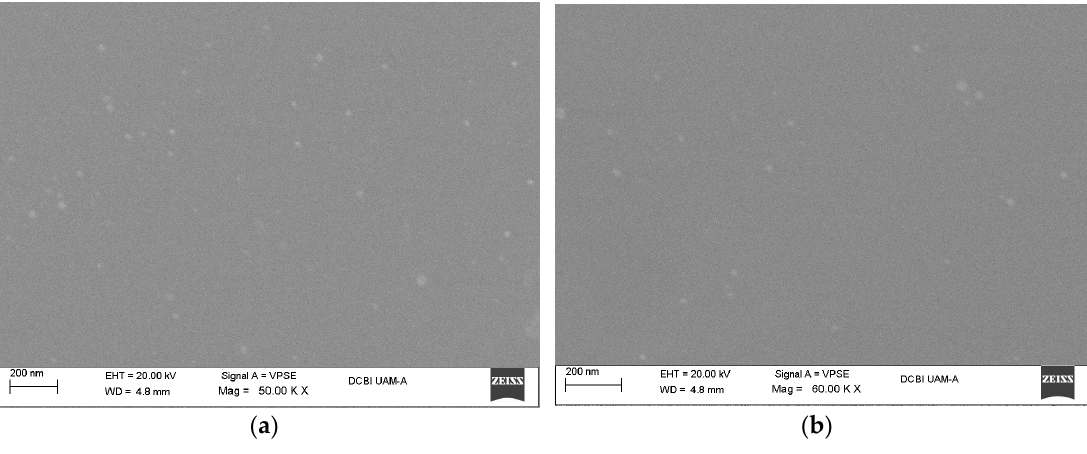
Figure 1. SEM micrographs of the silica nanoparticle dispersion with a 0.75 PHR (part of SiO 2 per hundred parts of resin) content, employing the sol-gel in situ technique: ( a ) Tetraethyl orthosilicate (TEOS) precursor; ( b ) 3-glycidoxipropyltrimethoxysilane (GPTMS) precursor.